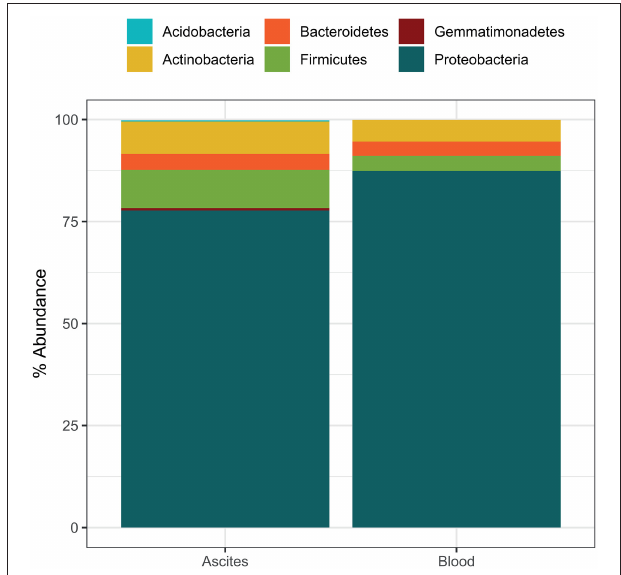
FIGURE 2 | Average microbiome phylum composition in ascites and blood samples ( n = 10